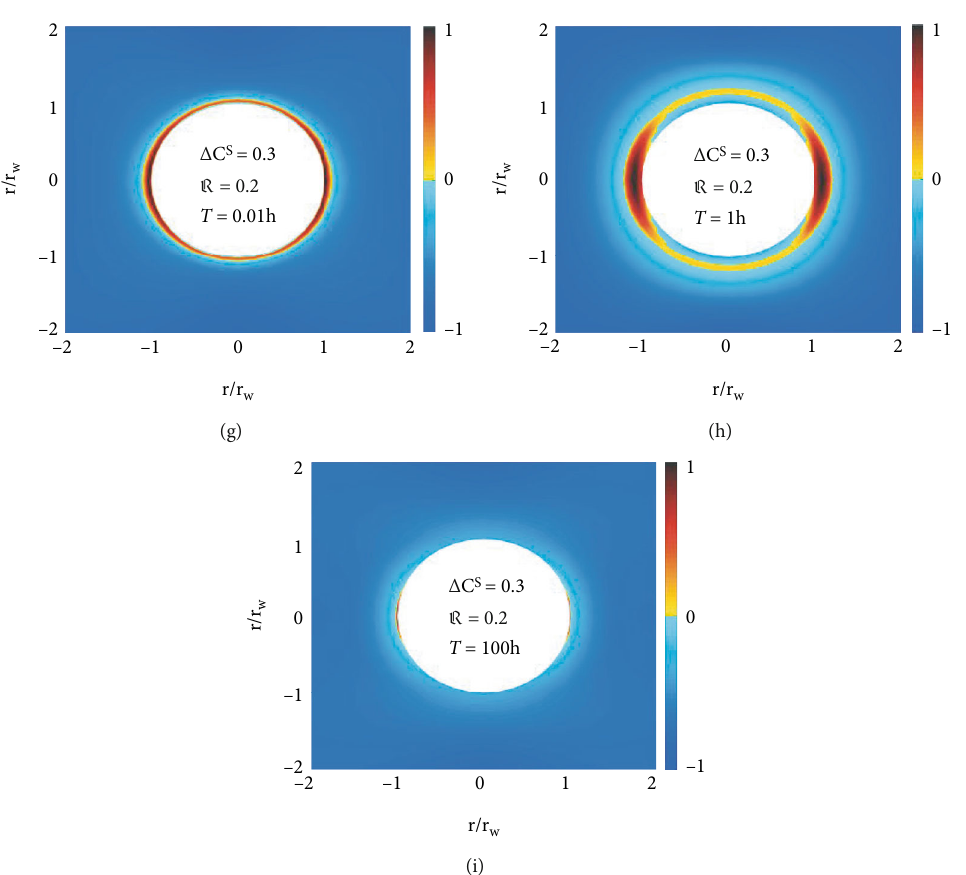
Figure 16: Damage zone around the wellbore (a) 0.01h, (b) 1 h, and (c) 100h after drilling for a solute concentration di ff erence of 0.1; (d – f) for a solute concentration di ff erence of 0.2; and (g – i) for a solute concentration di ff erence of